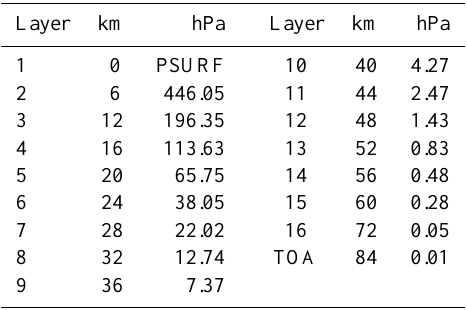
Table 2. The 16-layer pressure grid. Altitudes are given in kilo- metres and hectopascal for the lowest layer boundary. The surface pressure from the meteorology data (“PSURF”) is used as the low- est boundary for layer 1. The top of atmosphere (TOA) is the top boundary of layer